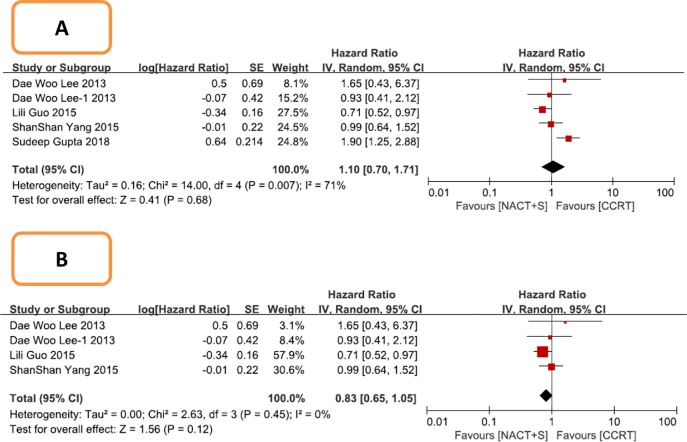
Forest plot of disease free survival (DFS) for patients with stage IIB cervical cancer.A: Including all studies; B: After excluding one Indian study.